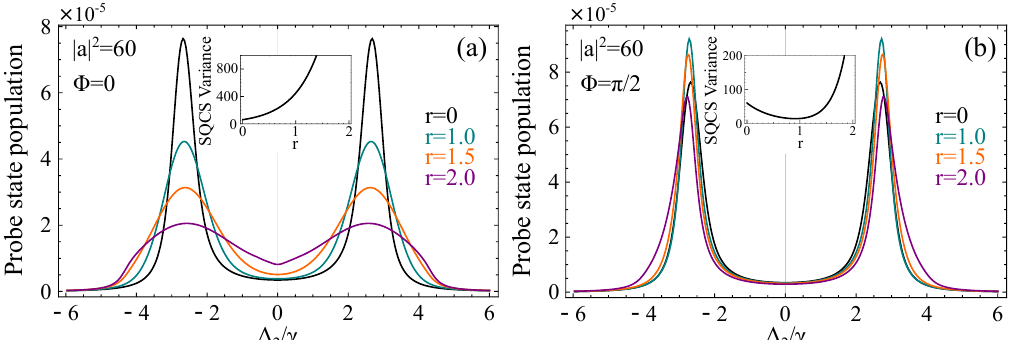
Figure 4. ( a ) Population of the probe state | b (cid:105) as a function of ∆ 2 for different degrees of squeezing and Φ = 0. Inset: Variance of the SQCS according to Equation (13) for Φ = 0. ( b ) Population of the probe state | b (cid:105) as a function of ∆ 2 for different degrees of squeezing and Φ = π /2. Inset: Variance of the SQCS according to Equation (13) for Φ = π /2. In both panels, | a | 2 = 60, T = 30 γ − 1 , g 1 = 0.7 γ , and ∆ 1 = 0. Black lines: r = 0, teal lines: r = 1, orange lines: r = 1.5, and purple lines: r =